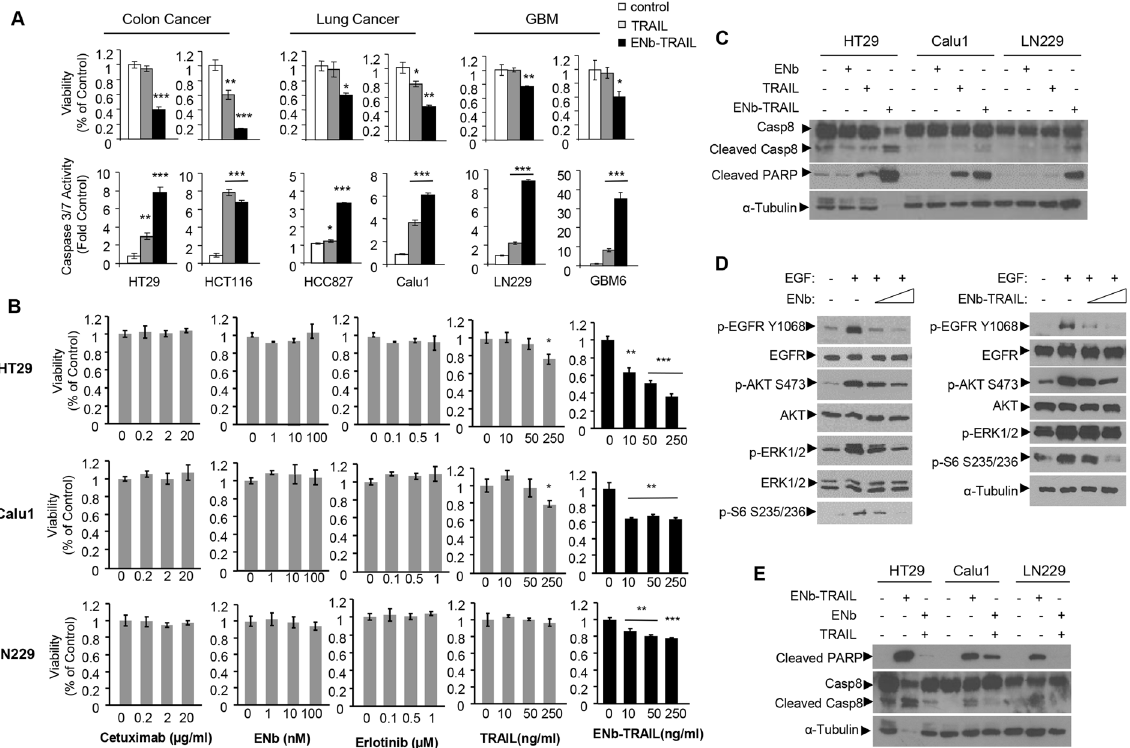
Figure 1. ENb-TRAIL has superior efficacy in cancer cells resistant to EGFR-targeted therapy and DR agonist TRAIL in vitro . ( A ) Cell viability and caspase 3/7 activity of tumor cells from different cancer types in response to 24 h treatment with TRAIL (50 ng/ml) or ENb-TRAIL (50 ng/ml). ( B ) Cell viability of HT29, Calu1 and LN229 cells in response to 24 h treatment with Cetuximab, ENb, Erlotinib, TRAIL or ENb-TRAIL. ( C ) Western blot showing the induction of apoptosis in tumor cells 24 h-post treatment with ENb-TRAIL (50 ng/ml) as compared to ENb (100 nM) or TRAIL (50 ng/ml). ( D ) Western blot analysis of EGFR signaling in ENb or ENb-TRAIL treated LN229 cells. ( E ) Western blot analysis showing the induction of apoptosis in ENb-TRAIL vesus the combination of ENb and TRAIL treated tumor cells (post 24 h treatment). * P < 0.05, ** P < 0.005 and *** P = 0.0001 determined by unpaired t test. Error bars indicate SD. Western blots were cropped to show specific bands only. For uncropped blots see Fig.